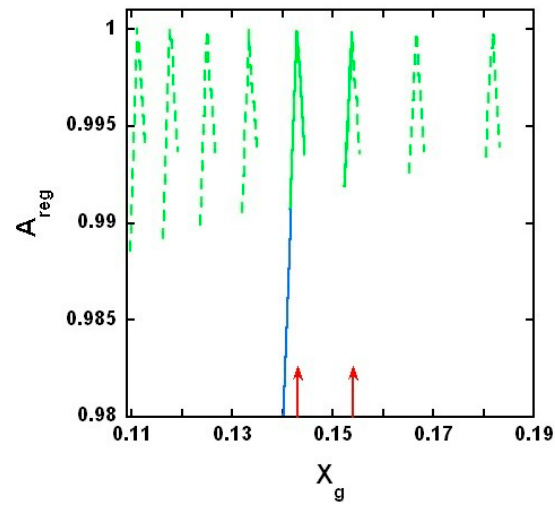
Figure 10. Proportion of regularly packed membrane area. Regular area fraction, A reg is plotted against the gramicidin mole fraction, X g . Green lines: the curves of regular area fractions calculated around the critical gramicidin mole fractions, by Equation (4). Green dashed lines are theoretically calculated but not experimentally supported. At X g < 0.143 the theoretically predicted peaks would appear experimentally if more than 12 DMPC’s were able to condense to a gramicidin dimer. Green solid lines are theoretically calculated and experimentally supported. One of the red arrows is at the measured lower limit of critical mole fractions, (Figures 1–4). The other red arrow is at the measured upper limit of the critical mole fractions, (Figure 5) which is also the solubility limit of gramicidin in DMPC bilayer. Gramicidin precipitates from the gramicidin/DMPC bilayer above this mole fraction (see explanation to Figure 5). The blue line is the assumed change of A reg if there is no critical gramicidin mole fraction below 0.143. If the vertical axis started from A reg = 0 and the horizontal axis from X g = 0, then the blue line would go from ( A reg = 1, X g = 0.143 ) to ( A reg = 0, X g = 0 ). The model parameters are listed in Table S1 and the energy difference was: ε s g − ε u g = 0